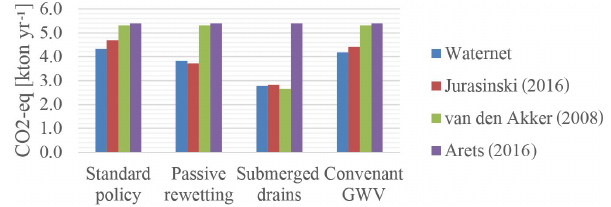
Figure 6. GHG emissions with four different policies in polder sub- unit